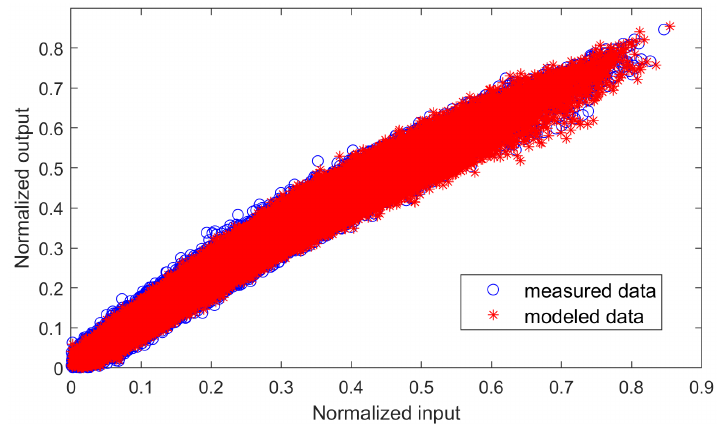
Figure 8. AM-AM characteristics of both the measured and modeled PA output data, considering 100 coefficients of a GMP behavioral model selected with DOMP. The resulting NMSE is − 33 dB.